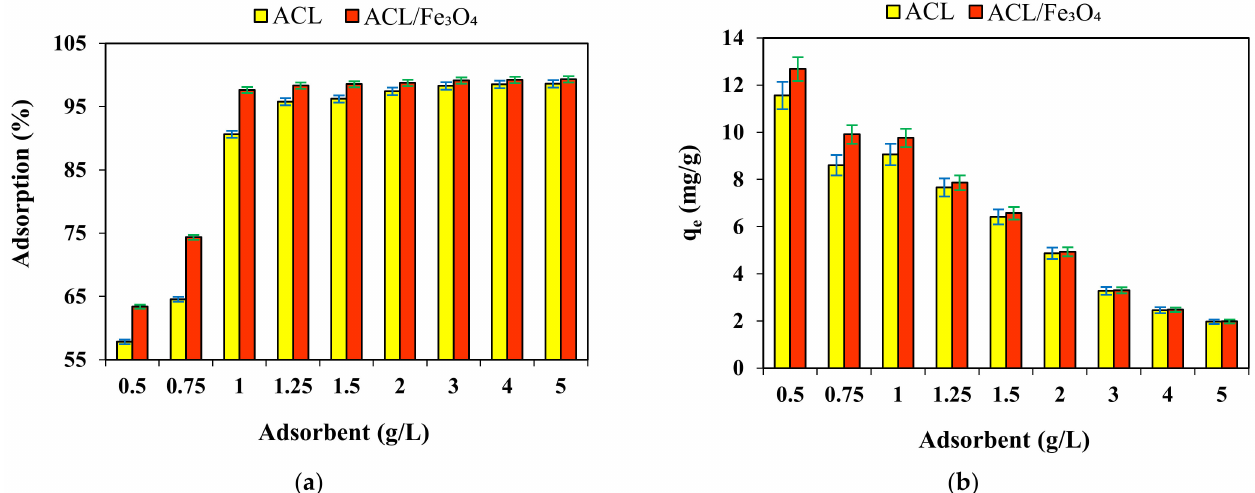
Figure 7. Effect of adsorbent dose on ( a ) adsorption efficiency, and ( b ) adsorption capacity (pH = 9, temperature 25 ◦ C, initial CV dye concentration 10 mg /L, contact time for ACL and ACL/Fe 3 O 4 magnetic nanocomposite 80 and 60 min, respectively). Data are mean of triplicate measurements and error bars indicate SD